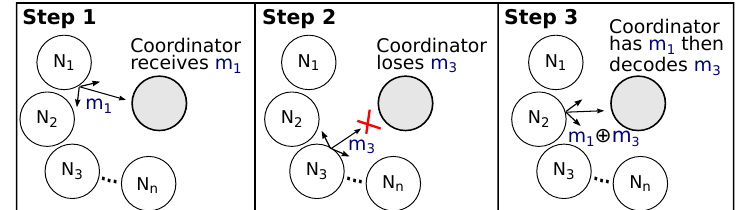
Figure 1. A scenario of using Network Coding to increase the reliability of a wireless star network. Node N 2 overhears the messages m 1 and m 3 and acts as a relay rebroadcasting a single coded message m 1 ⊕ m 3